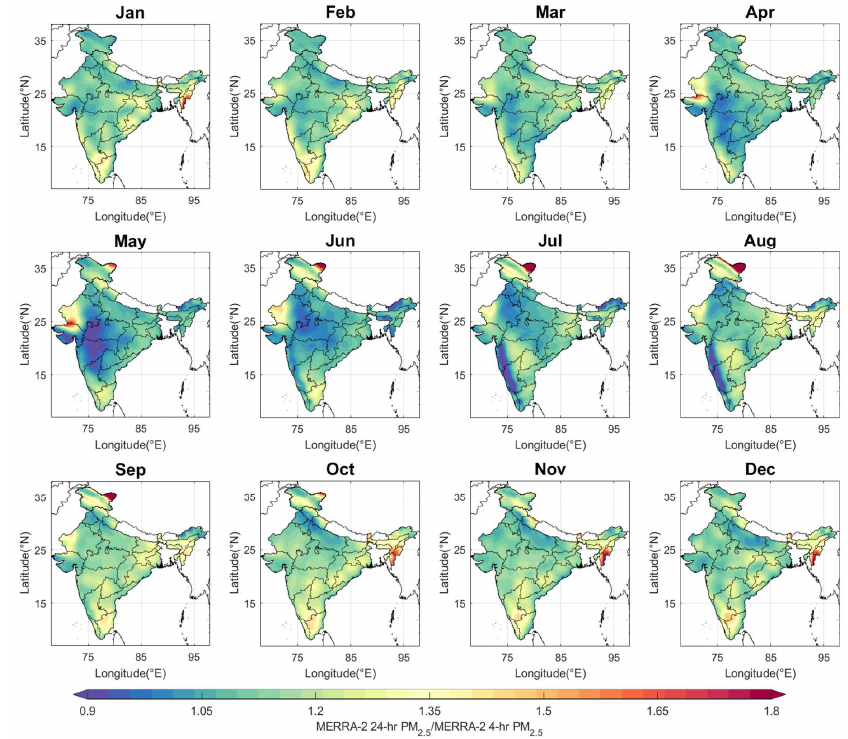
Figure A5. Spatial patterns of mean monthly diurnal scaling factor over India derived from MERRA-2 data. The diurnal scaling factor values are derived for each day during the entire study period and used to estimate 24-hr PM 2.5 from instantaneous (i.e., during the satellite-overpass time) PM 2.5 .